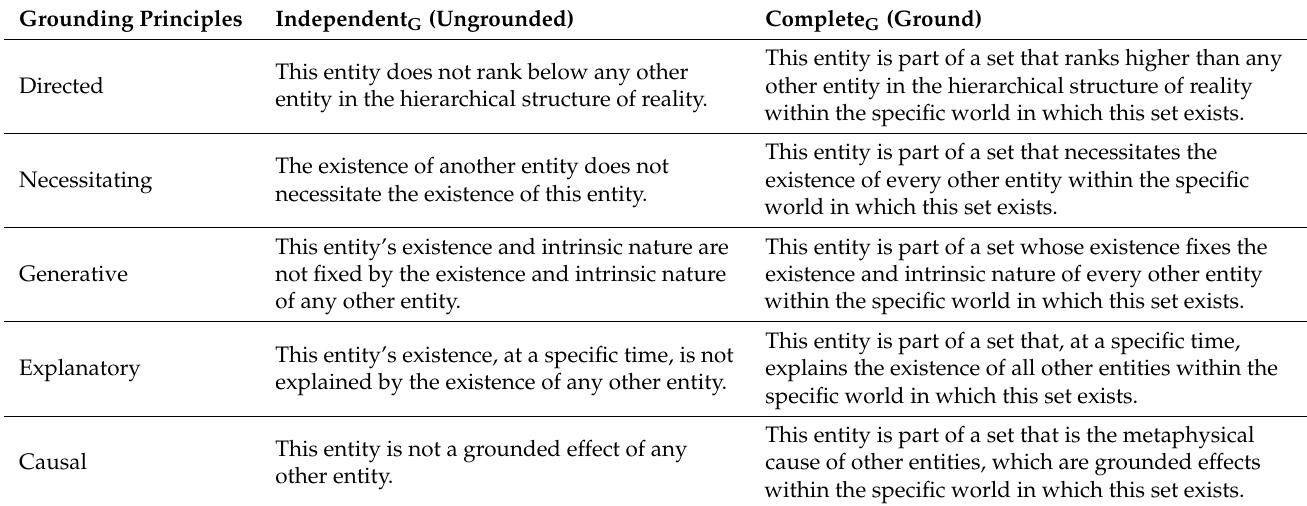
Table 1. Fundamentality Grounding